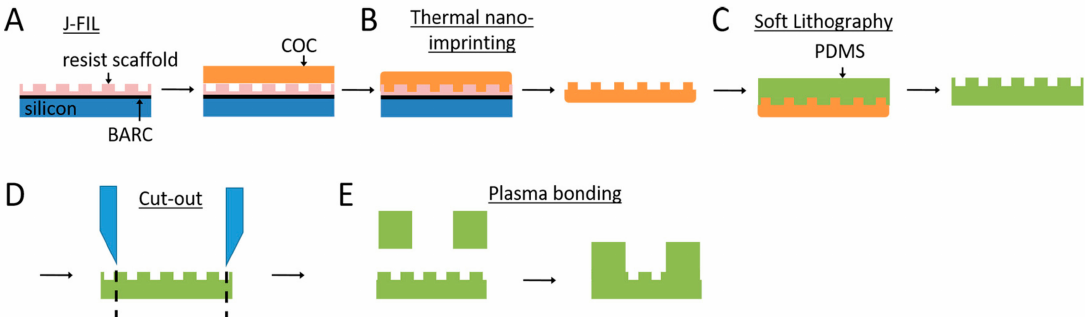
Figure 1. Fabrication process of polydimethylsiloxane (PDMS) constructs for 3D neuronal cell culture